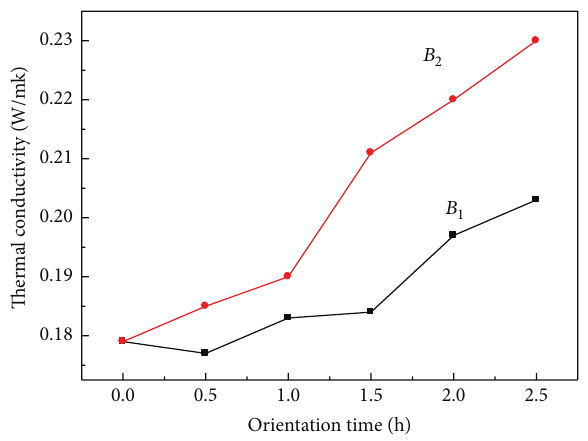
Figure 6: Effect of orientation time and magnetic intensity on thermal conductivity of composite (volume fraction = 6%, at 80 ∘ C test temperature).